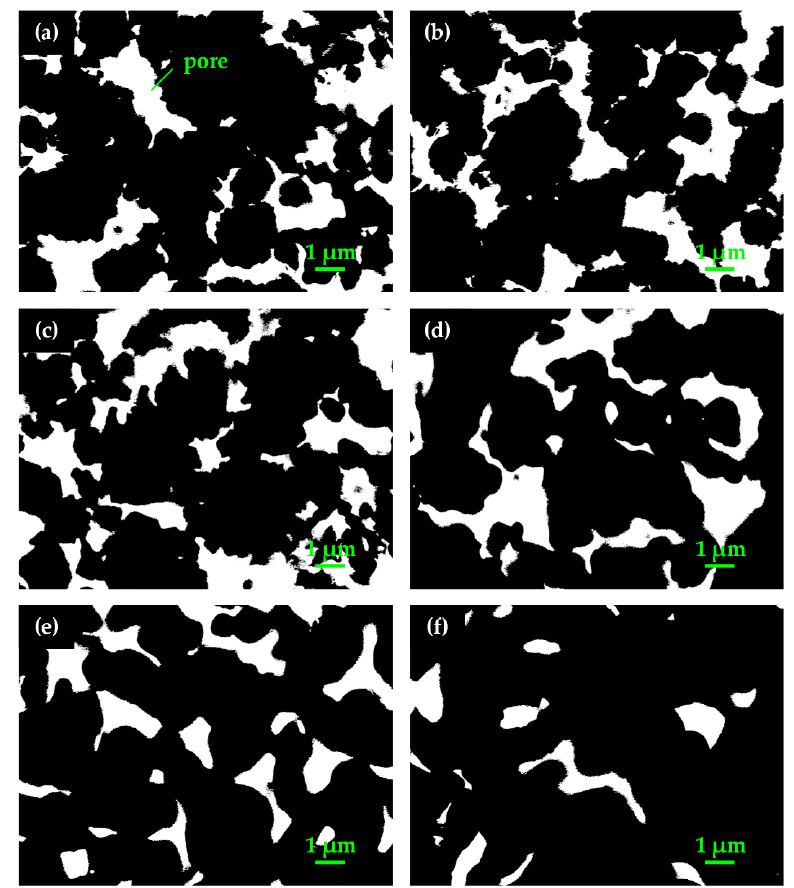
Figure 5. Cross-section morphology of pores in green slices and wicks sintered at various tempera- tures: ( a ) green slice, ( b ) 200 ◦ C, ( c ) 300 ◦ C, ( d ) 400 ◦ C, ( e ) 500 ◦ C, ( f ) 600 ◦